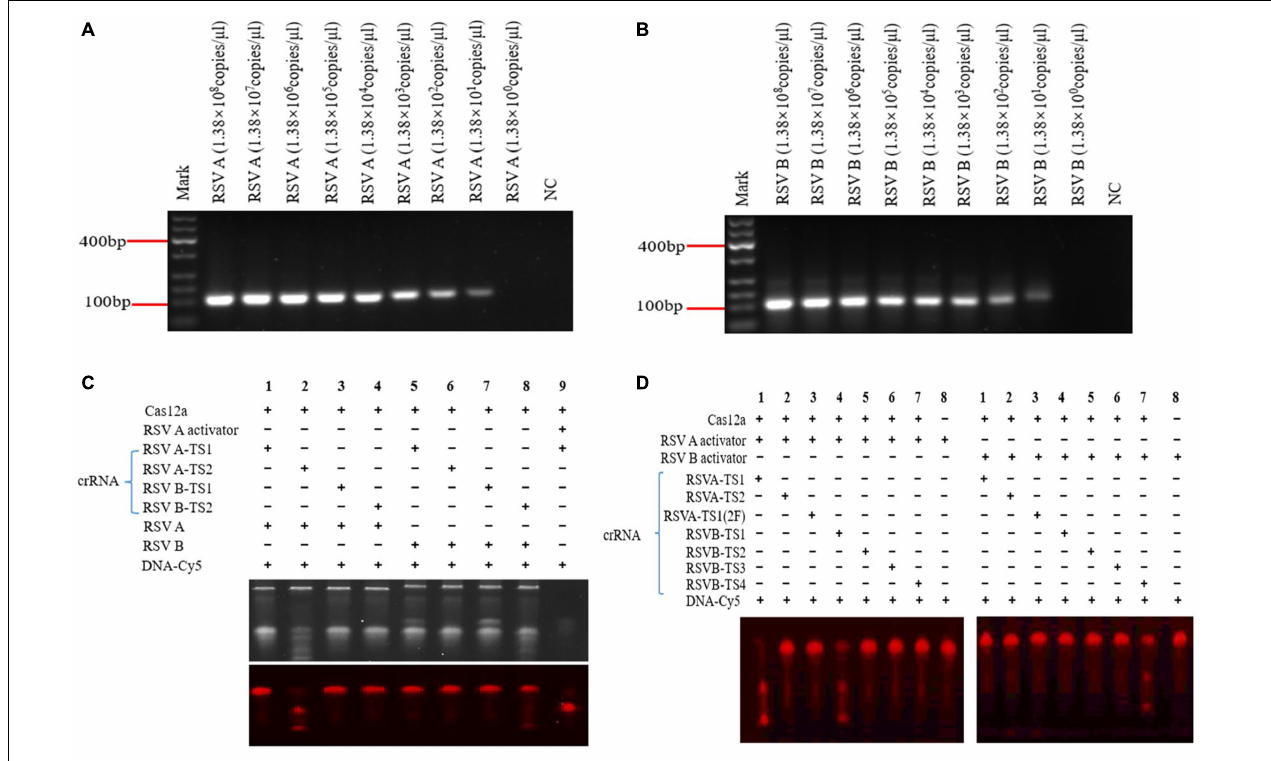
FIGURE 2 | Recombinase polymerase amplification (RPA) on RSV A and RSV B sequences and screening for effective crRNAs. RPA RSV A (110 bp) and RSV B (122 bp) products at different pUC57 plasmids concentrations (A,B) . Screening effective crRNAs to activate Cas12a to cleave RSV A and RSV B (C,D) . RSV A-TS1-2F crRNA: a modified RSV A-TS1 crRNA. DNA-Cy5: a reporter fragment labeled with fluorophore Cy5. Under yellow, white, and violet light irradiation, the target strip on the gel showed red fluorescence (DNA-Cy5), and the small strip below the target strip showed Cas12a cleavage (C bottom and D). NC: negative control (water) (A,B) . NC: DNA-Cy5 and water (C,D) . Marker: 600 bp DNA marker. +, added reagent; – no added reagent. All experiments were repeated three times ( n =